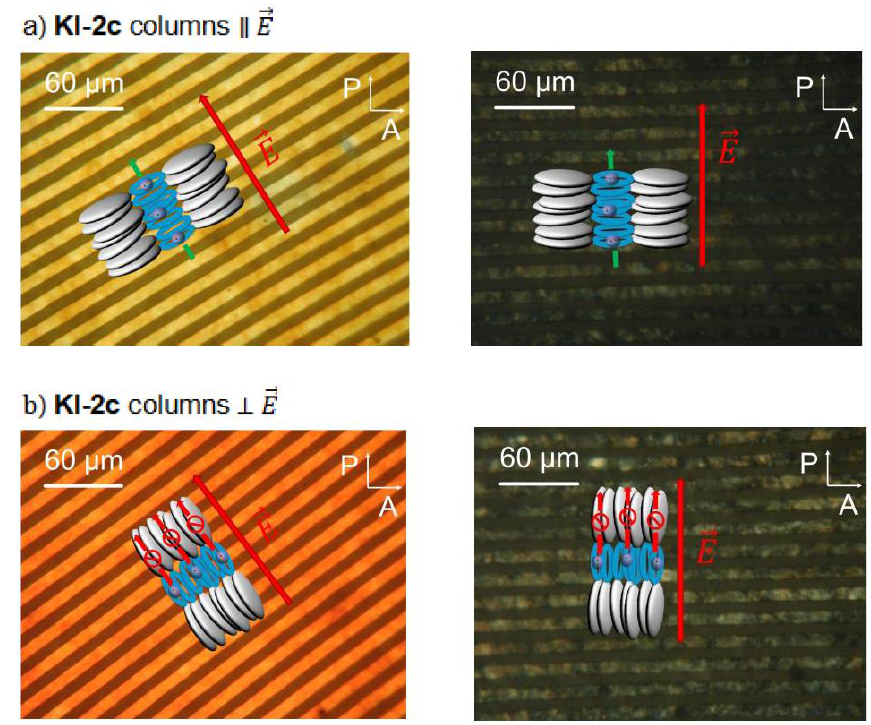
Figure 10. Bright and dark state polarizing micrographs of KI-2c films on interdigitating electrodes with columns aligned parallel to the electric field direction ( a ) and columns aligned perpendicular to the electric field direction ( b ).